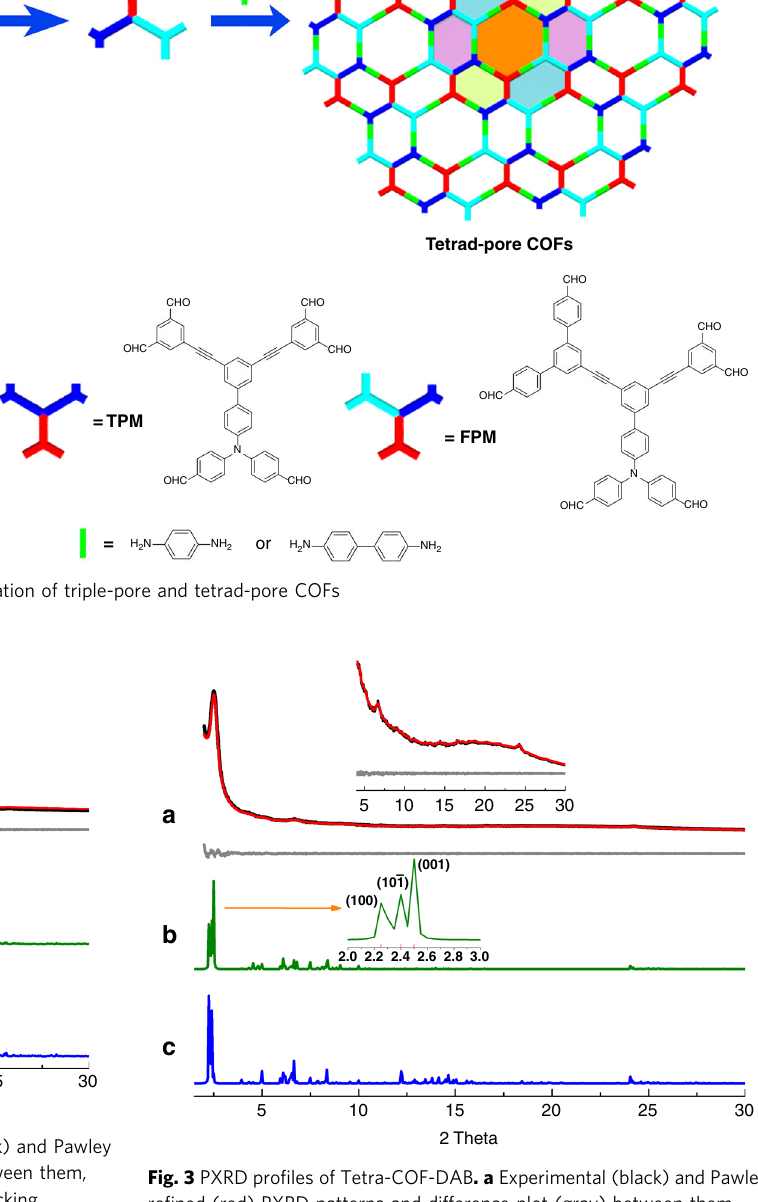
a = 36.79 Å, b = 3.68 Å, c = 39.23 Å, α = γ = 90°, β = 120°, with R wp = 3.16% and R p = 2.36%. The coincidence of the re fi ned difference plot. As revealed by Fig. 2a, the re fi ned PXRD pattern